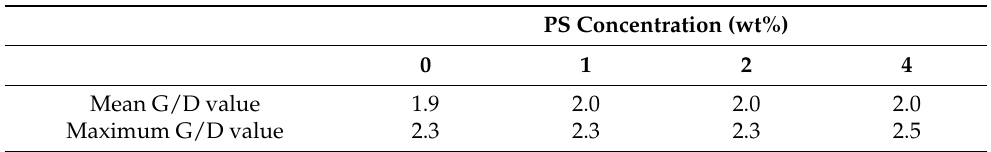
Table 1. Mean and maximum G/D values obtained for various carbon nanotube samples grown with incrementally higher concentrations of polystyrene